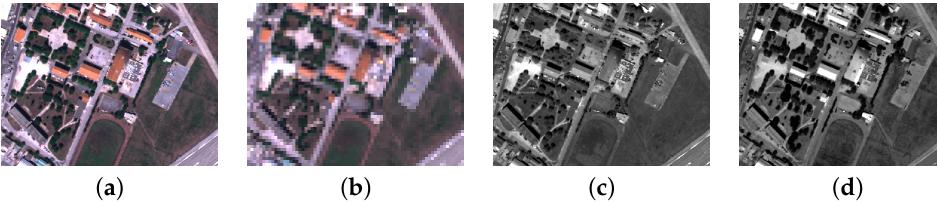
Figure 6. “Toulon” dataset (spatial resolutions in brackets; RGB representation for HS images). ( a ) REF (1.5 m), ( b ) HS (6 m), ( c ) PAN, visible (1.5 m), ( d ) PAN, SWIR (1.5 m).